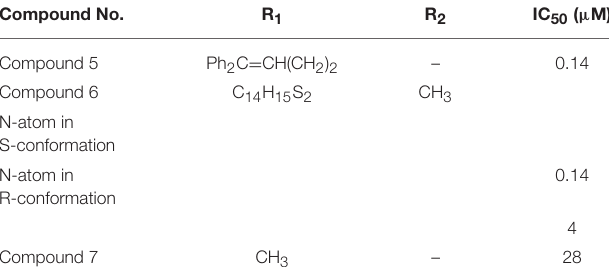
TABLE 3 | Chemical structures of exo-THPO derivatives along with inhibitory potency (IC 50 ) values against hGAT 1. (R)-exo-THPO *R 1 and R 2 = H (R-configuration)